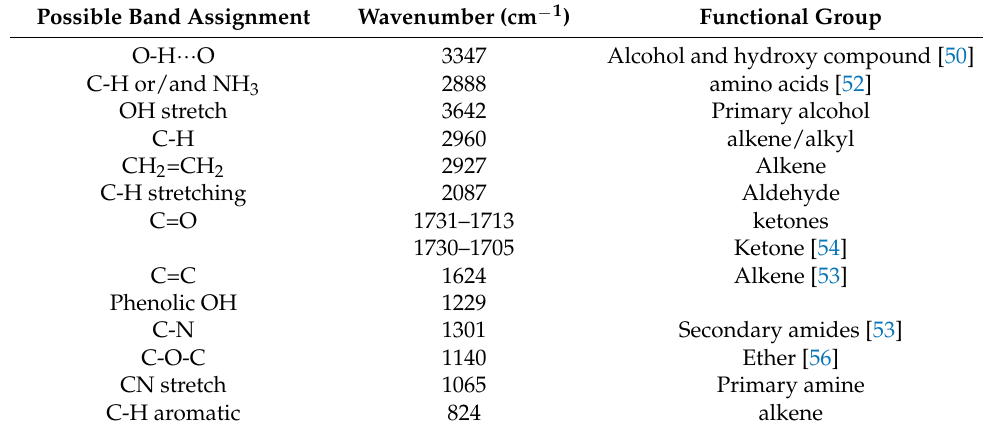
Table 6. Main functional groups assigned to the different vibrations present in FTIR